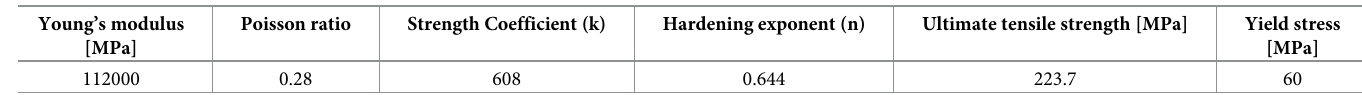
Table 1. Measured mechanical properties of annealed copper.